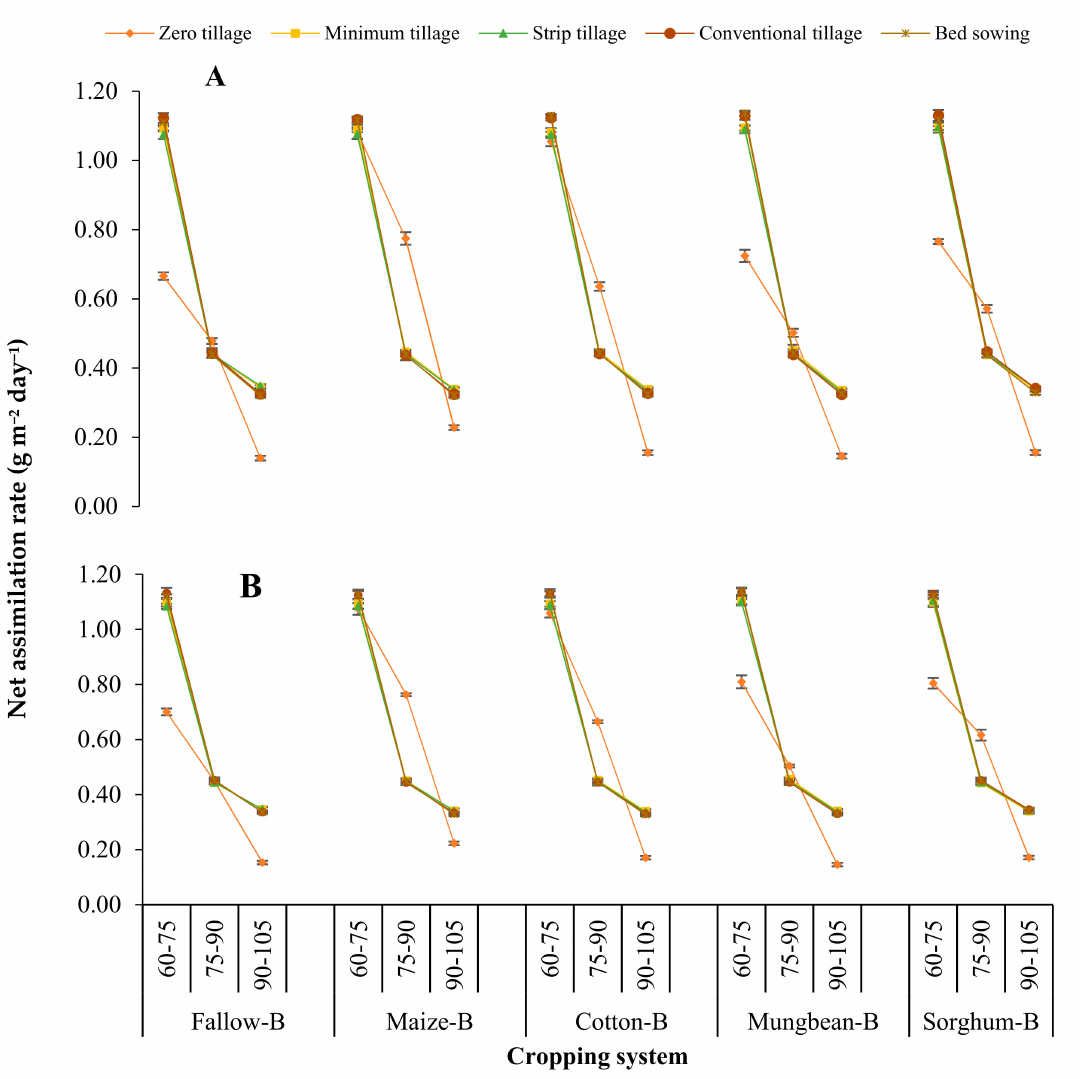
Figure 8. Interactive effect of tillage systems and barley-based cropping systems on net assimilation rate (g m − 2 day − 1 ) of barley during 2017–2018 ( A ) and 2018–2019 ( B ) ± S.E. In the legend, Fallow-B = Fallow-barley, Maize-B = Maize-barley, Cotton-B = Cotton-barley, Mungbean-B = Mungbean-barley and Sorghum-B =